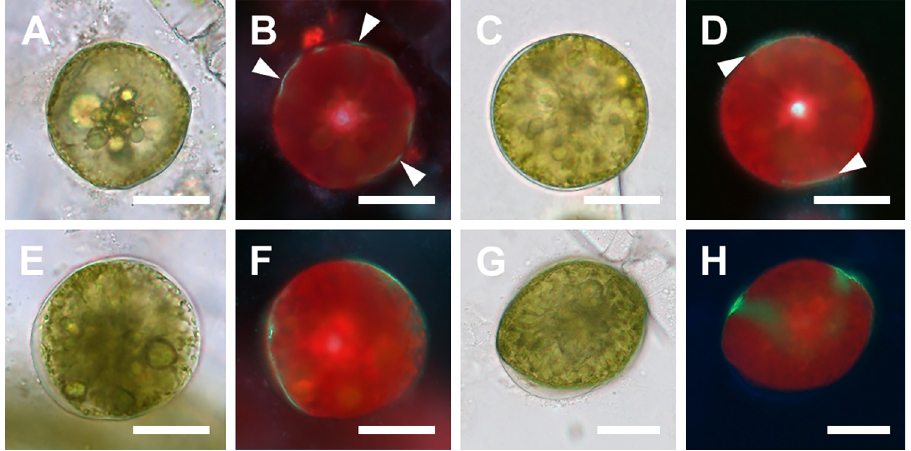
Fig 3. Zygotes and spherical auxospores (brightfield and PDMPO-labeled epifluorescence light microscopy). (A, B) Zygote or young spherical auxospore showing several islands of concurrent silicification of the cell wall (arrowheads in B), likely containing individual or clusters of siliceous scales. (C, D) Spherical auxospore showing deposition of silica in the equatorial region (arrowheads in D). (E, F) An auxospore showing more siliceous elements being deposited. Note the large area of silicification on the protoplast surface pulling away from the older part of the wall, left side. (G, H) A slightly ellipsoidal auxospore showing deposition of two epizonial bands, one arching towards the apex. All scale bars: 50 μ